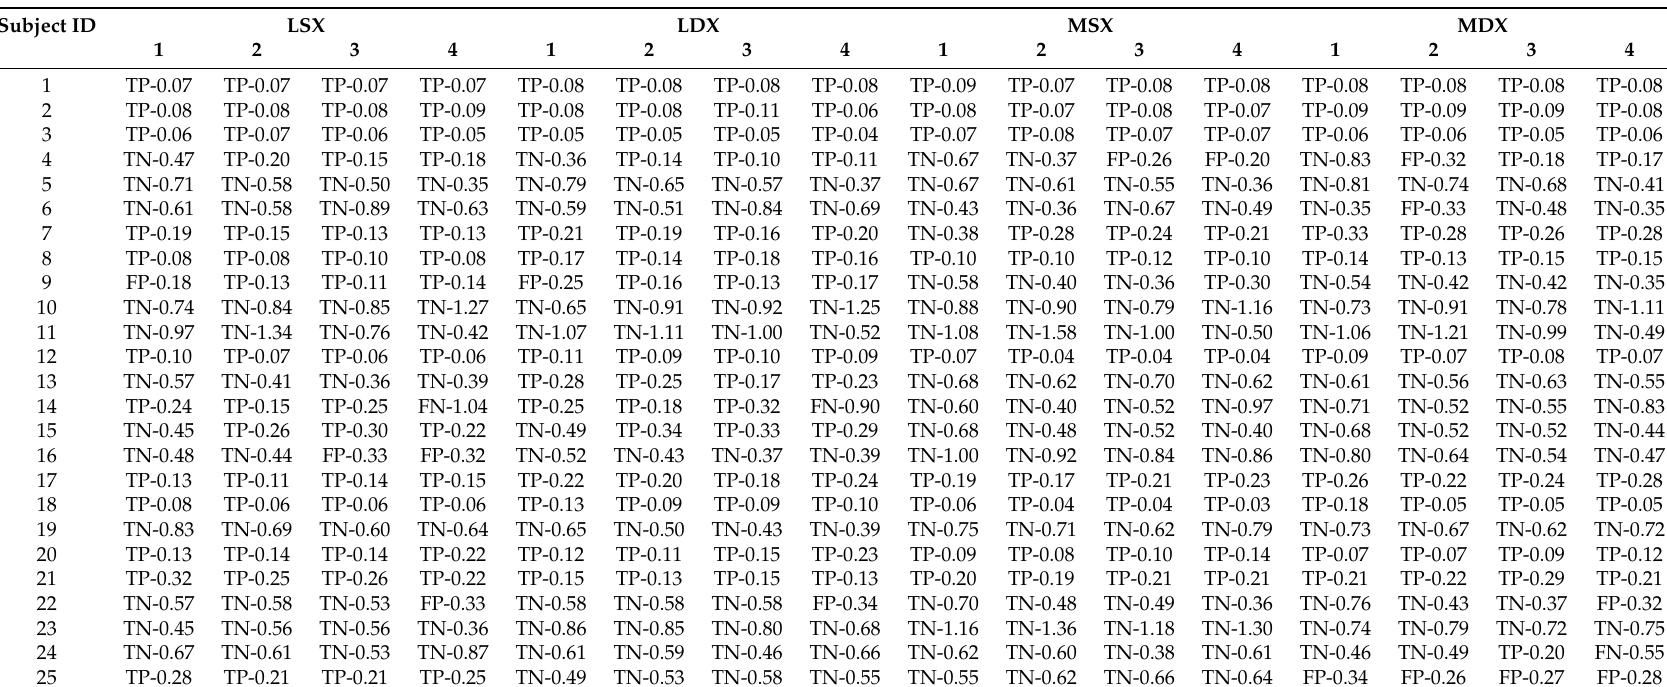
Table 2. Results of the FRR method for all 400 events. Each value contains the event classification and the relative ratio. It was used an FRR Threshold =